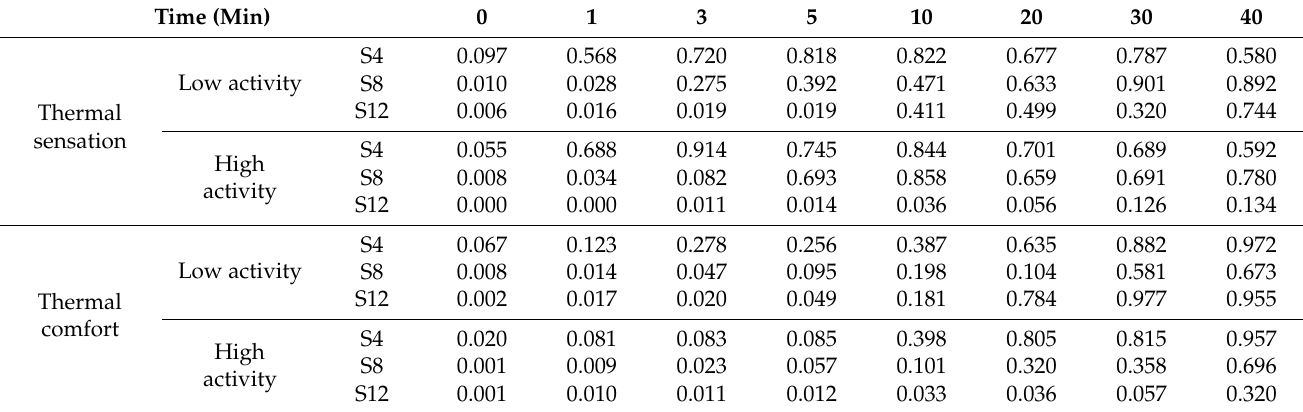
Table 5. Significance level of thermal sensation and thermal comfort.